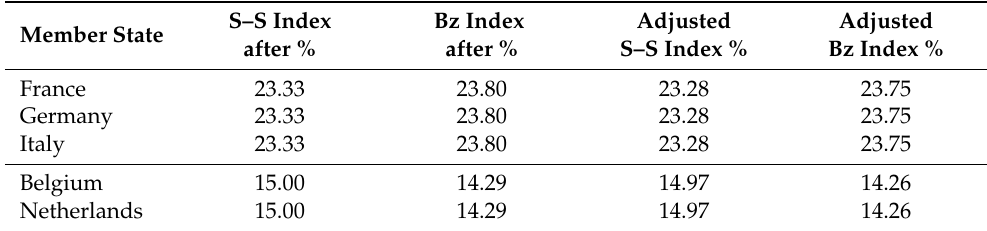
Table 2. The effect of Luxembourg’s departure from the Council of Ministers in 1958, Shapley–Shubik (S–S) and Banzhaf